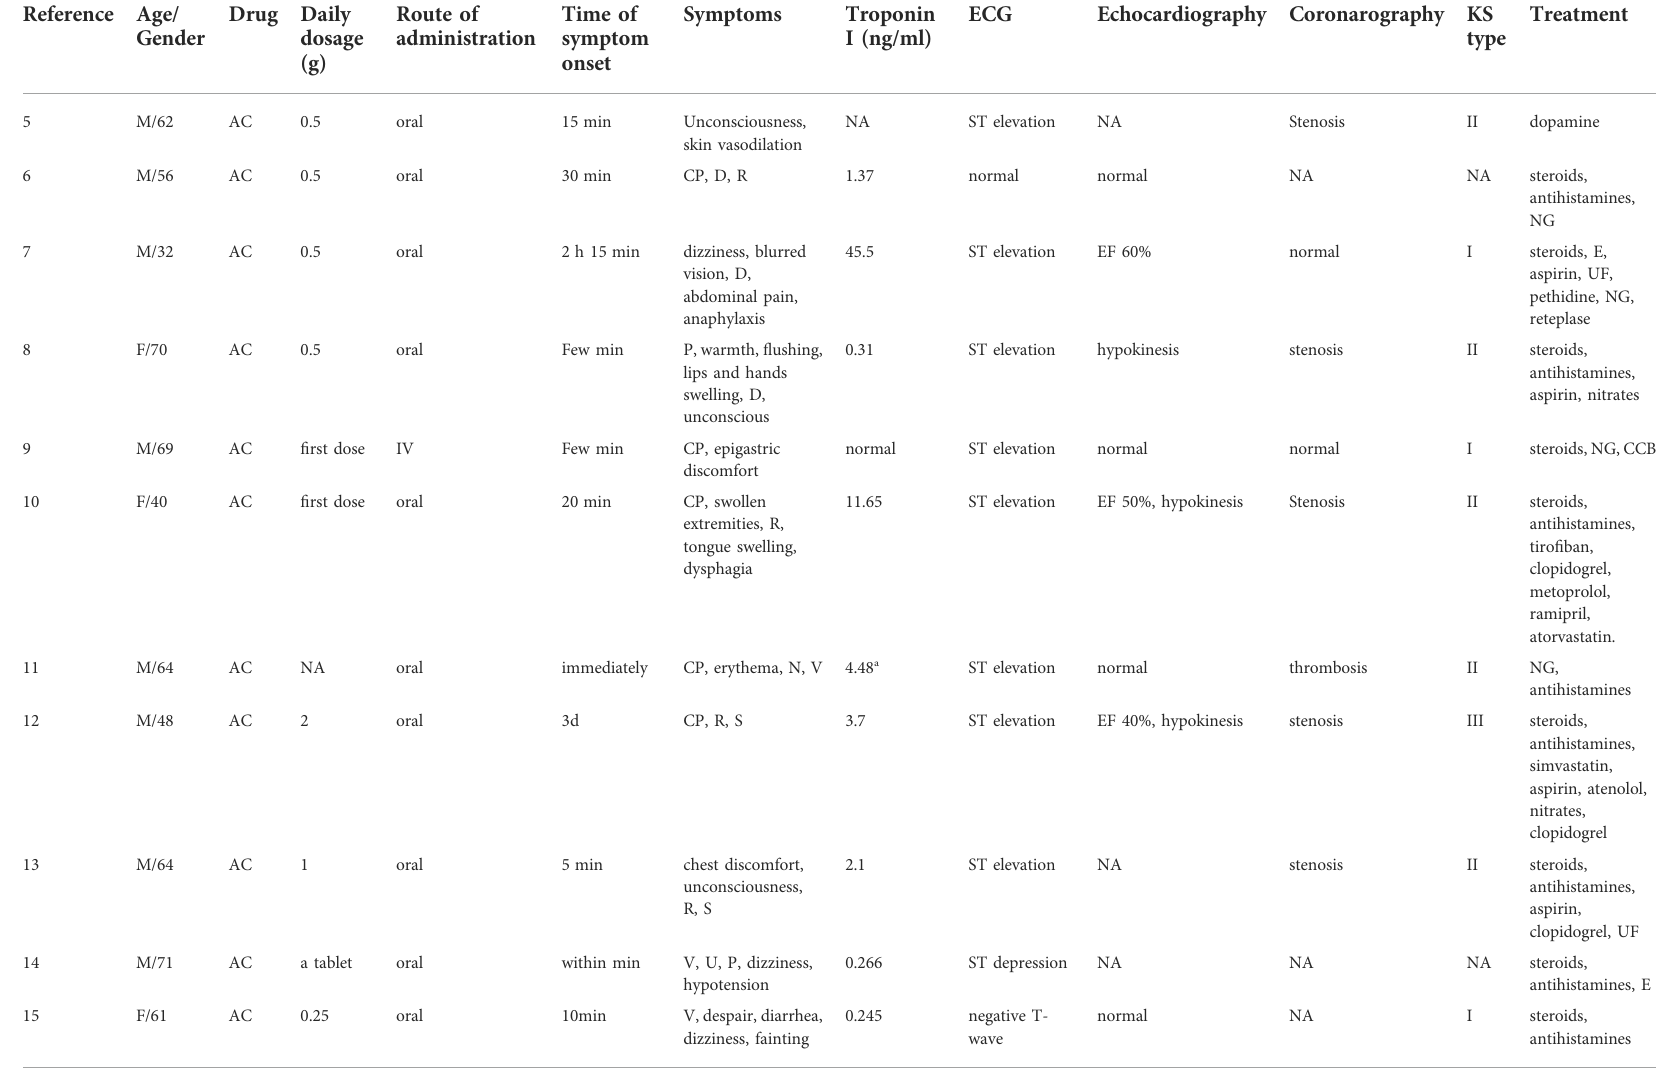
TABLE 1 Summary of clinical information of 33 patients with amoxicillin-induced Kounis